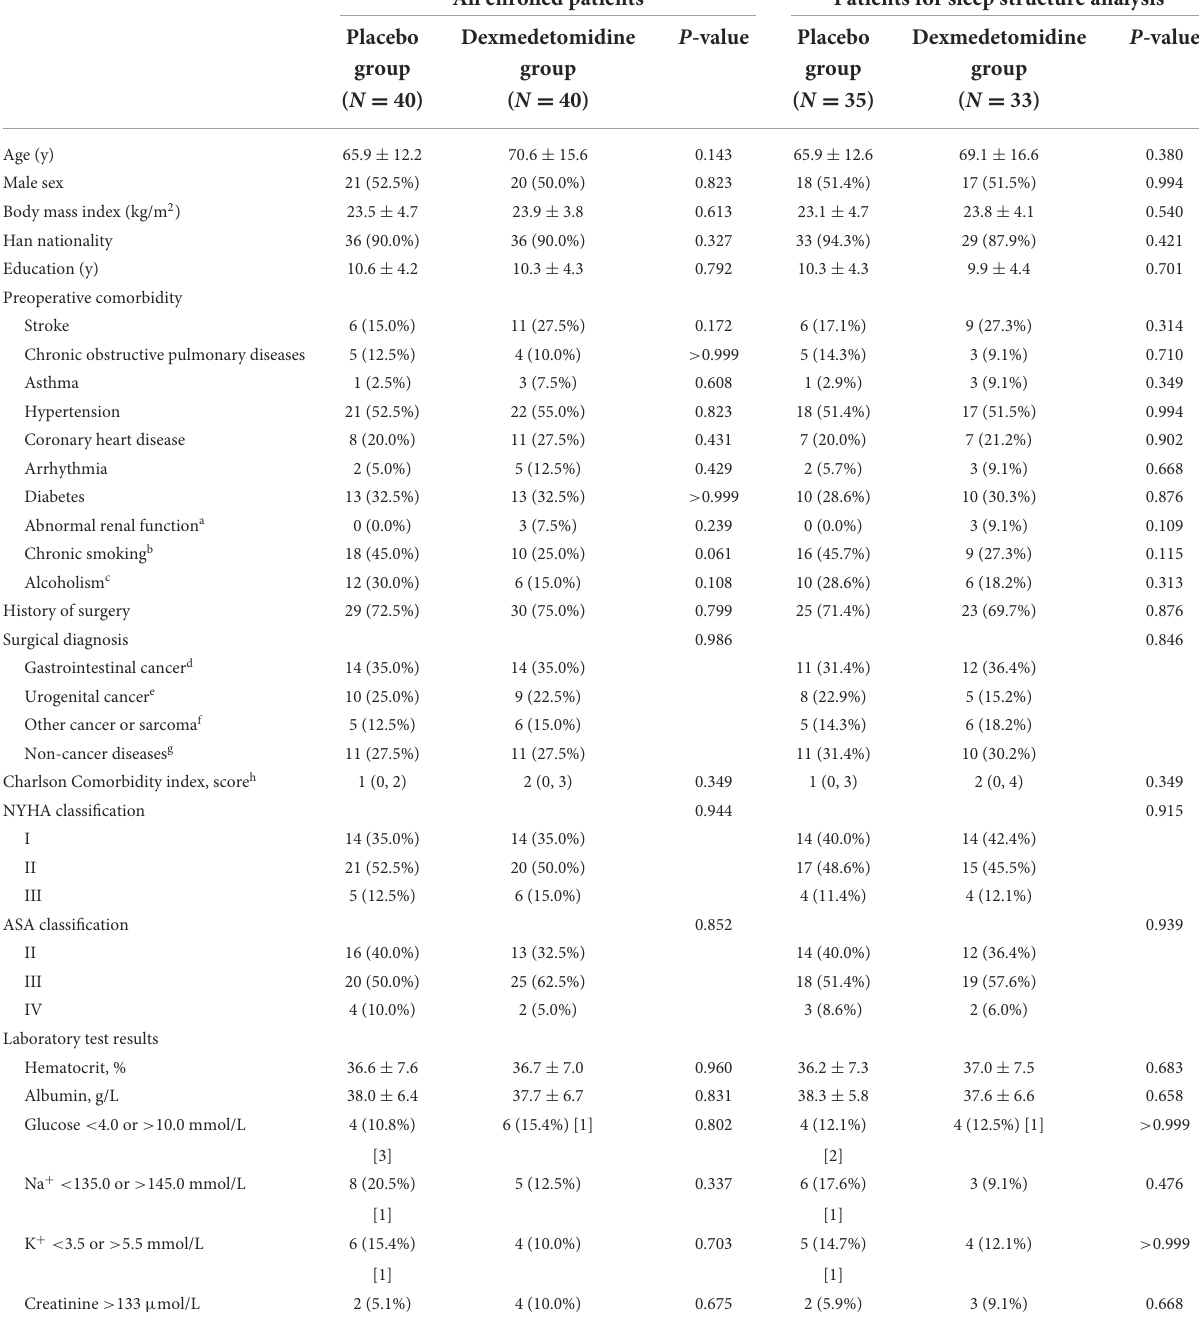
TABLE 1 Baseline